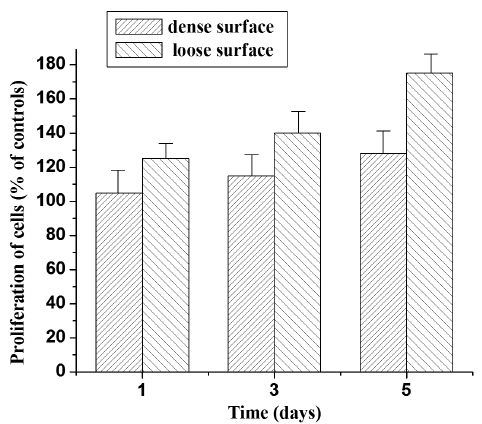
Figure 6. Proliferation of MC3T3-E1 cells on both surfaces of the HCP scaffolds. At the indicated time points, cell viability of the loose surface group was significantly higher than those of the dense surface group. Data are presented as means ± standard deviations for n=5.